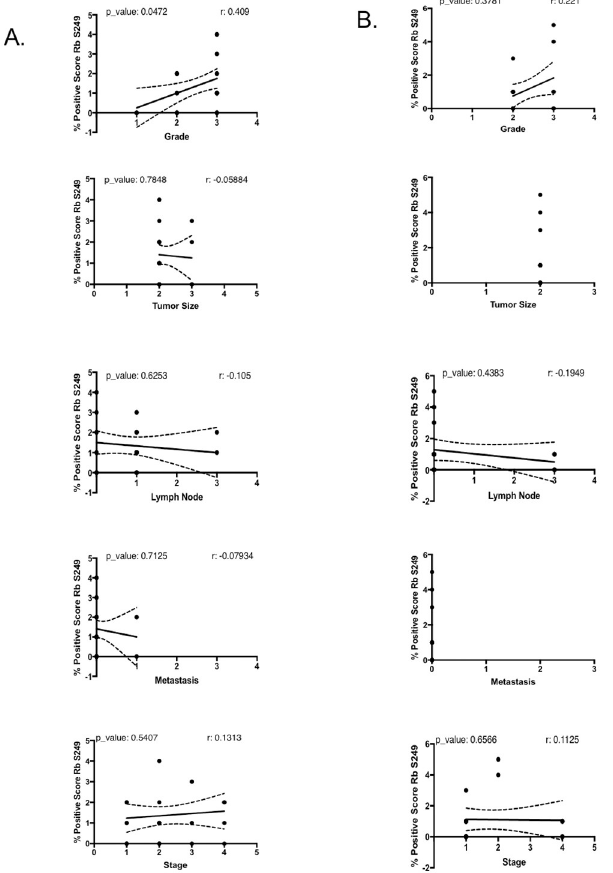
Fig 5. Rb S249 phosphorylation correlates with grading in SCC tumors. Correlation coefficient analyses to determine whether in the SCC subtype (A), the IHC score for Rb S249 phosphorylation correlates with any of the clinical parameters accompanying the tumor samples in the TMAs. In SCC, the IHC score for Rb S249 phosphorylation positively correlated only with tumor grade, with a correlation coefficient of 0.409, and a p-value of 0.0472. (B) In AC, Rb S249 phosphorylation did not correlate with any clinical